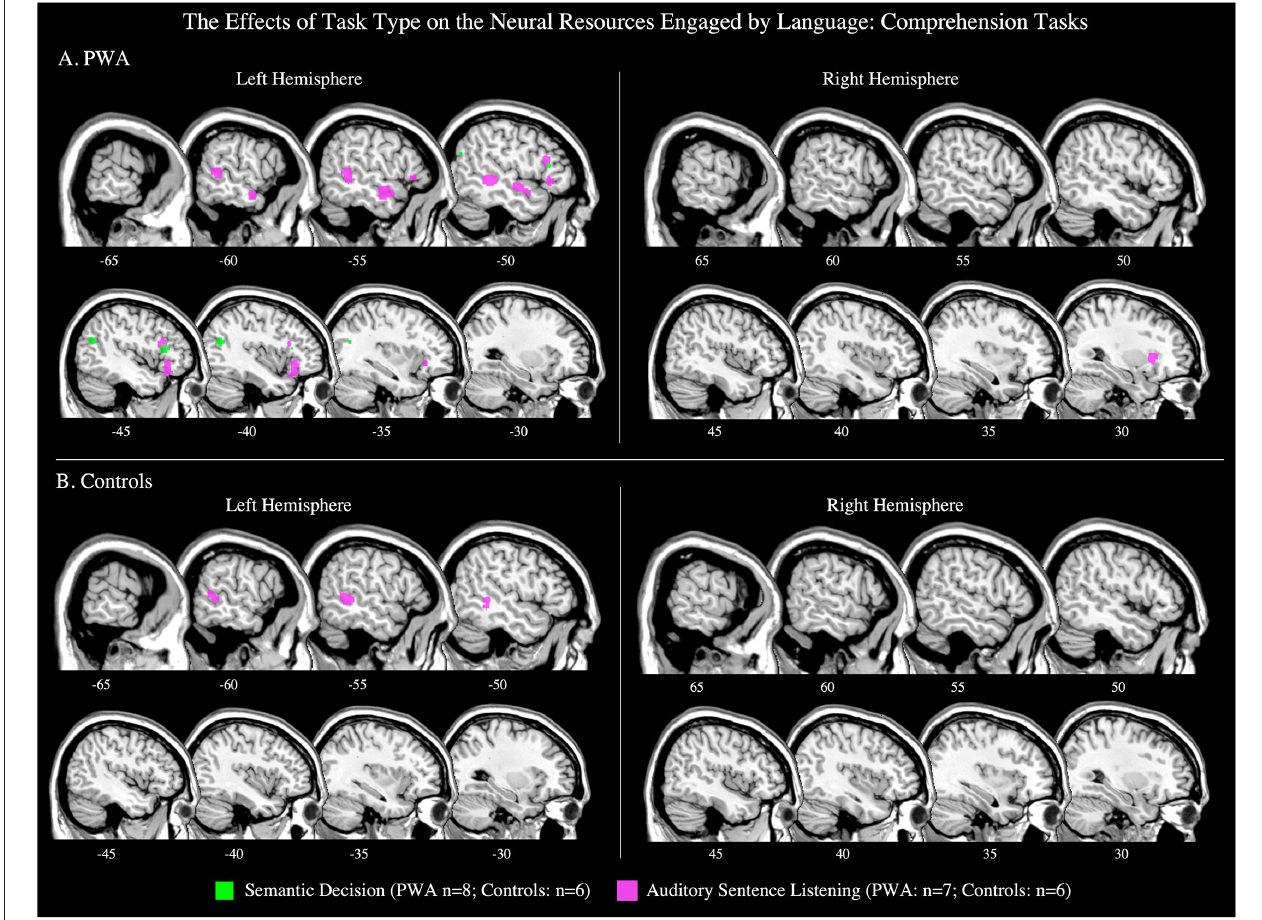
FIGURE 8 | Representative sagittal slices for the semantic decision and auditory sentence listening ALEs in (A) PWA and (B) controls ( p < 0.001 corrected). Sample size denotes the number of tasks included in the